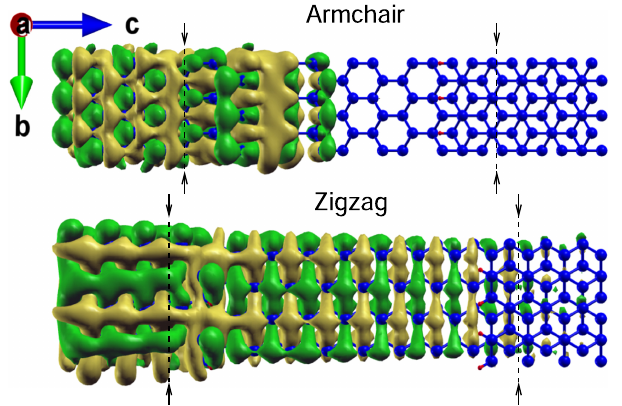
Fig. 3 First transmission eigenchannel wave functions. Results are given for the left-to-right transmission through the armchair and zigzag devices. Green and yellow colors represent the phases. Arrows mark the semiconductor-metal contacts.